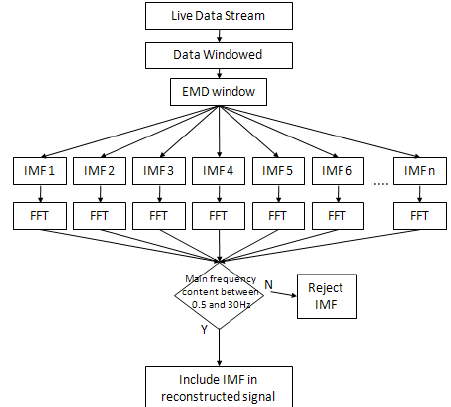
Figure 6. Dynamic EMD (empirical mode decomposition) filter structure showing the use of FFT (fast Fourier transform) to post process each IMF (intrinsic mode functions) prior to reconstruction. IMFs that fall outside of the frequency band (0.5 Hz–30 Hz) are excluded.